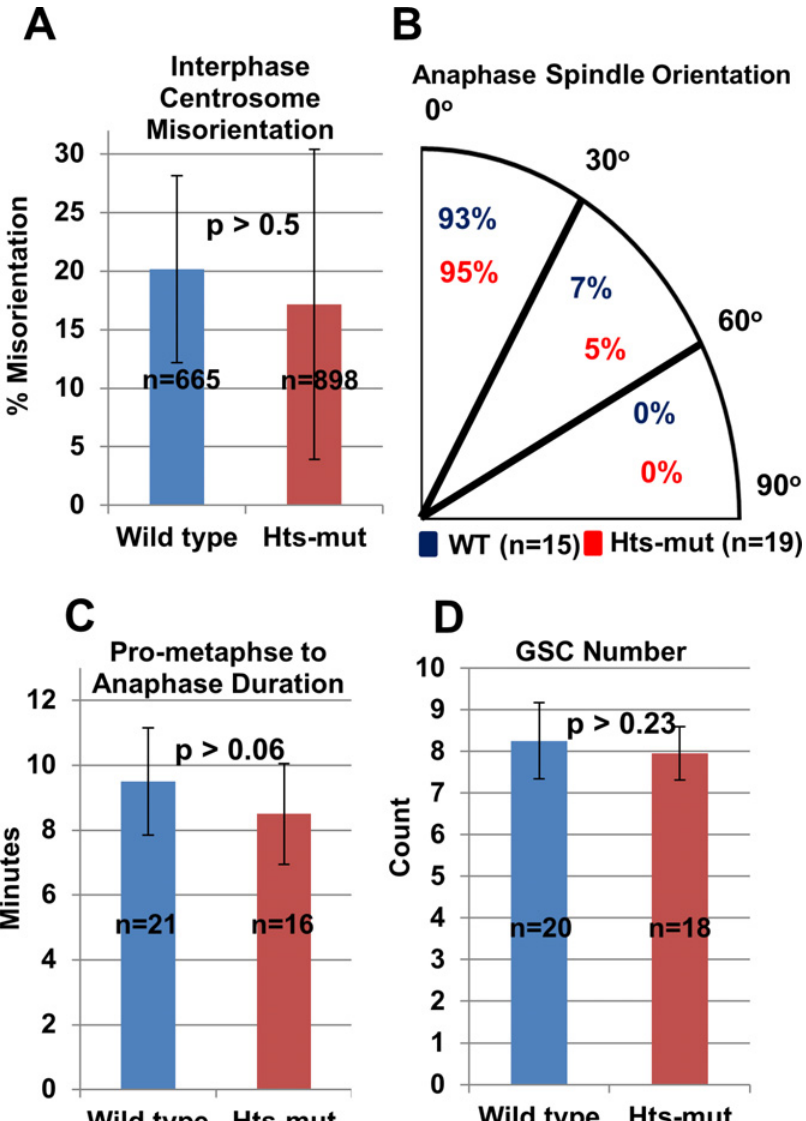
Fig 4. Spectrosome Knockout minimally affects centrosome orientation, spindle orientation, mitosis duration, and stem cell numbers in male GSCs. (A) Centrosome misorientation during interphase was analyzed from time lapse image sequences, and there is no significant difference between the hts-mut and the wild type. (B) There is minimal change in the spindle orientation between the hts-mut and the wild type. (C) Mitosis duration is not affected in hts-mut compared to the wild type when measured from nuclear envelope breakdown time to anaphase. (D) There is no significant difference for GSC number per testis in hts-mut and wild type